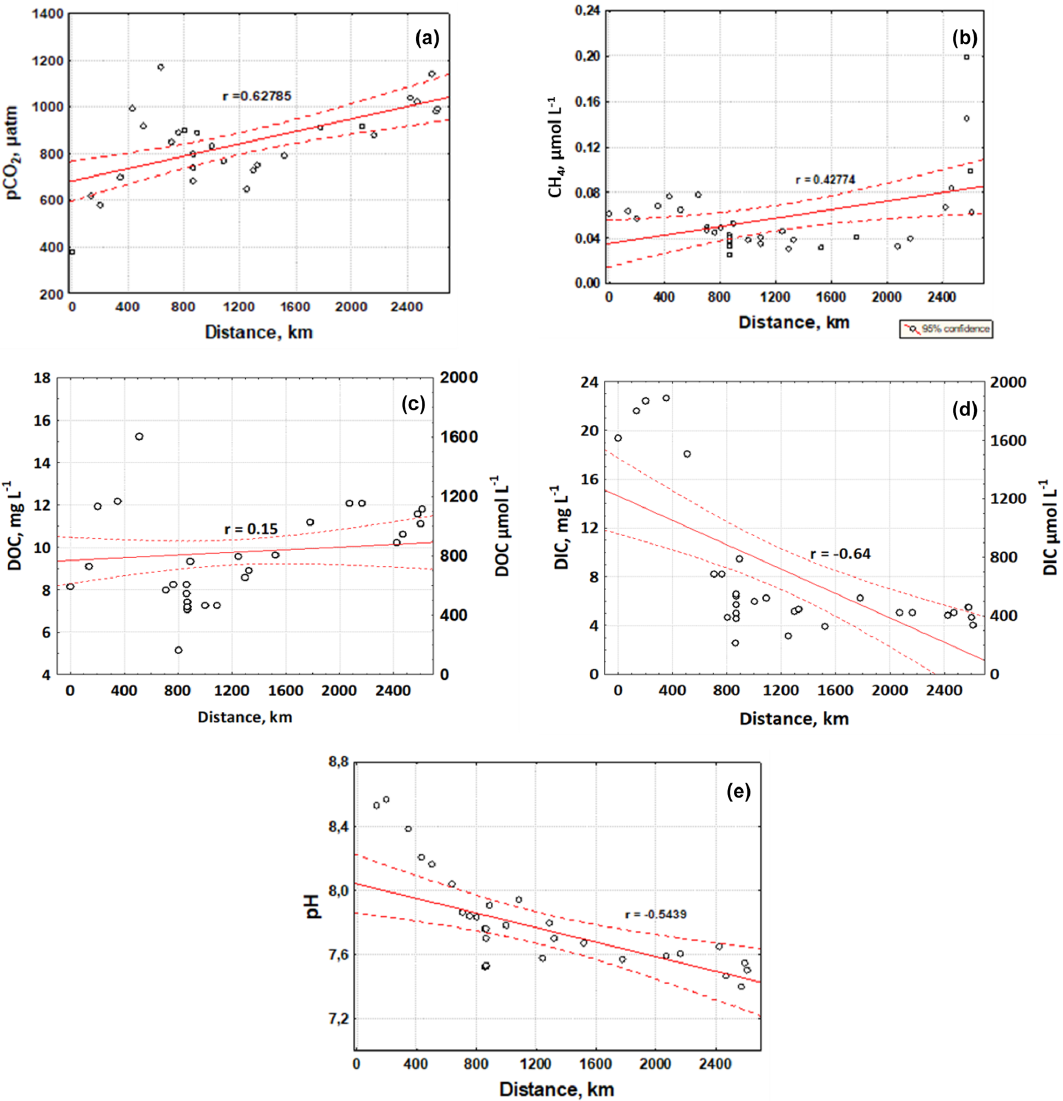
Figure 3. Averaged (over 20km distance) CO 2 (a) , CH 4 (b) , DOC (c) , DIC (d) , and pH (e) concentration over the distance of the boat route at the Lena River, from the southwest to